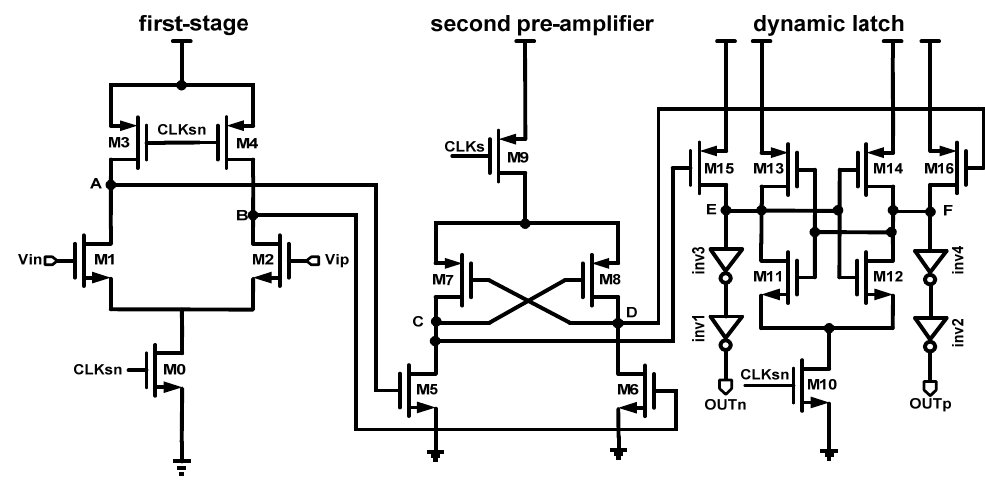
Figure 13. Dynamic comparator.